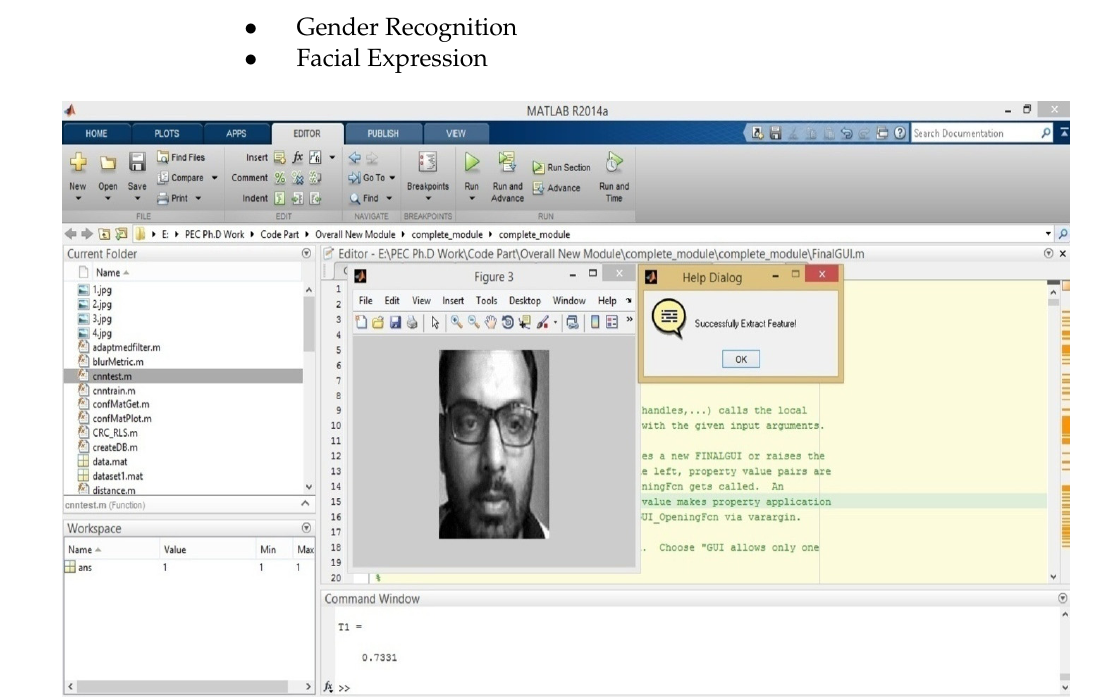
Figure 7. Five-Layer Alex-Net-based Architecture.